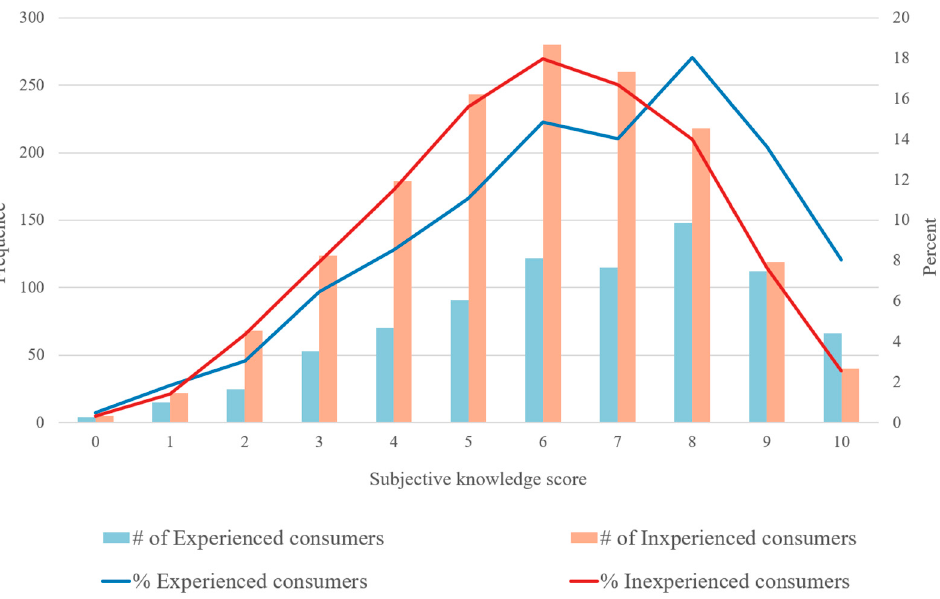
Figure 4. Distribution of subjective knowledge score based on consumption experience of functional eggs.